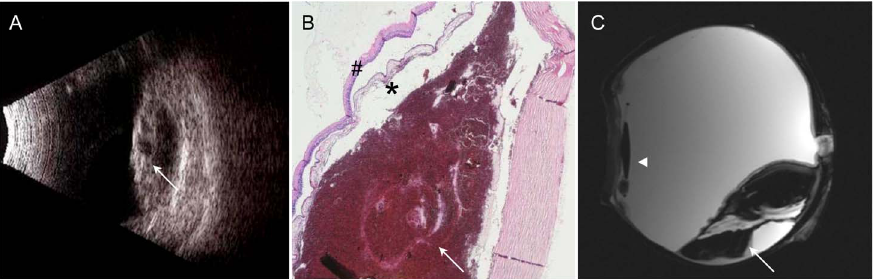
Figure 5. Subretinal bleeding with degenerative, atrophic choroid and retina. A – Sonography: highly reflective and detached cystic retina and choroidea (arrow); subretinal space with low internal reflectivity. B – H&E stain, 2 6 magnification: Peripapillary subretinal mass (arrow) with degenerative and atrophic lesions of the retina (hash) and choroid (asterisk). C – Sagittal T2w image: Subretinal mass of very low signal intensity with retinal detachment, fluid-fluid level (arrow), pseudophakia (arrowhead).